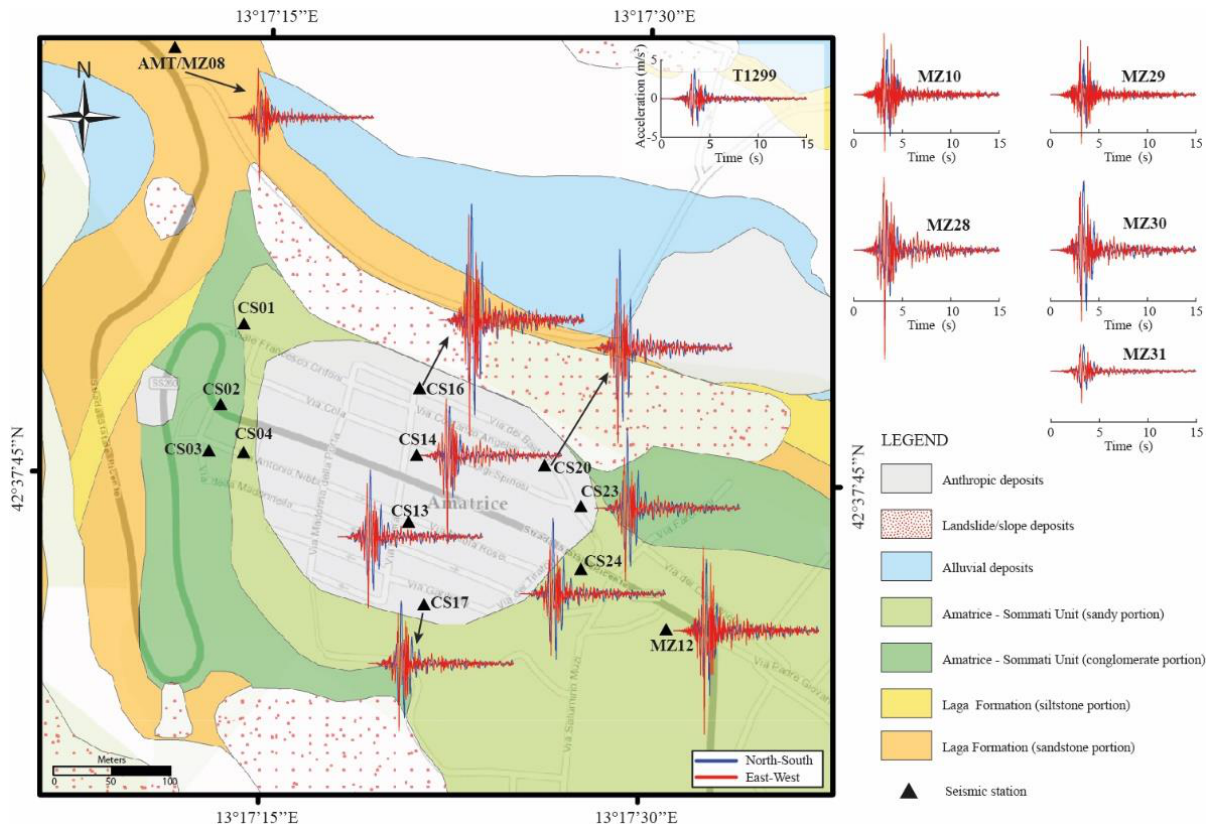
Figure 10. Blue (red) lines represent the north–south (east–west) components of the simulated seismograms of Mw 6.0, 24 August 2016, in Amatrice downtown at the seismic stations (black triangle). The seismograms sit on a schematic geological map of the Amatrice downtown (modified after [27]) generated by GIS (base map source: Esri, user community, geographic information system. Coordinate system and projection: World Geodetic System 1984–Web Mercator Auxiliary Sphere).